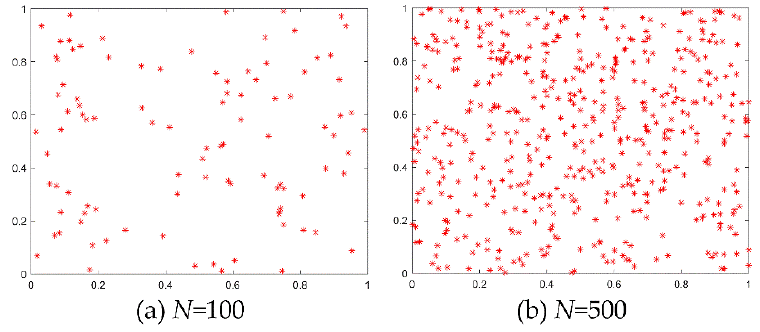
Figure 5. Pseudo ‐ random number initialization population distribution.